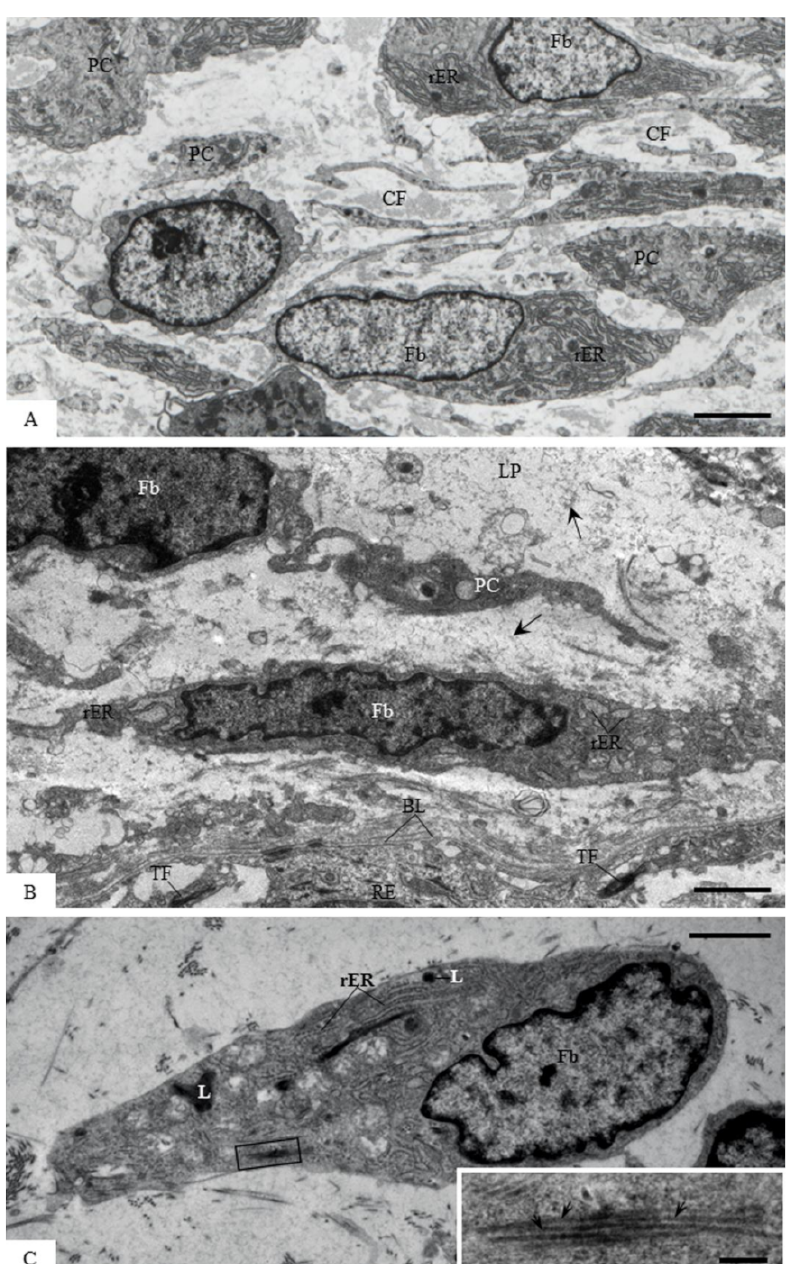
Figure 4. Electron micrographs of portions of lamina propria of the eruptive pathway of first molars of 9- ( A ) and 16- ( B and C ) day-old rats. In A —fibroblasts (Fb) exhibiting several rough endoplasmic reticulum profiles (rER) in their large cytoplasm are surrounded by numerous collagen fibrils (CF). PC, cell portions. Bar: 5 µ m. In B —Fibroblasts (Fb) containing few rough endoplasmic reticulum profiles (rER) in the scarce cytoplasm are surrounded by granular material (arrows) in the extracellular matrix. PC, cell portion; RE portion of the reduced enamel epithelium; TF, bundles of tonofilaments; BL, basal lamina. Bar: 5 µ m. C —a polarized fibroblast (Fb) with irregular nucleus exhibits collagen fibrils (outlined area) apparently internalized in the large cytoplasm. The inset of the outlined area shows the profiles of banded collagen fibrils (arrows). rER, rough endoplasmic reticulum profiles; L, lysosomes. Bars: 3 µ m and 0.4 µ m